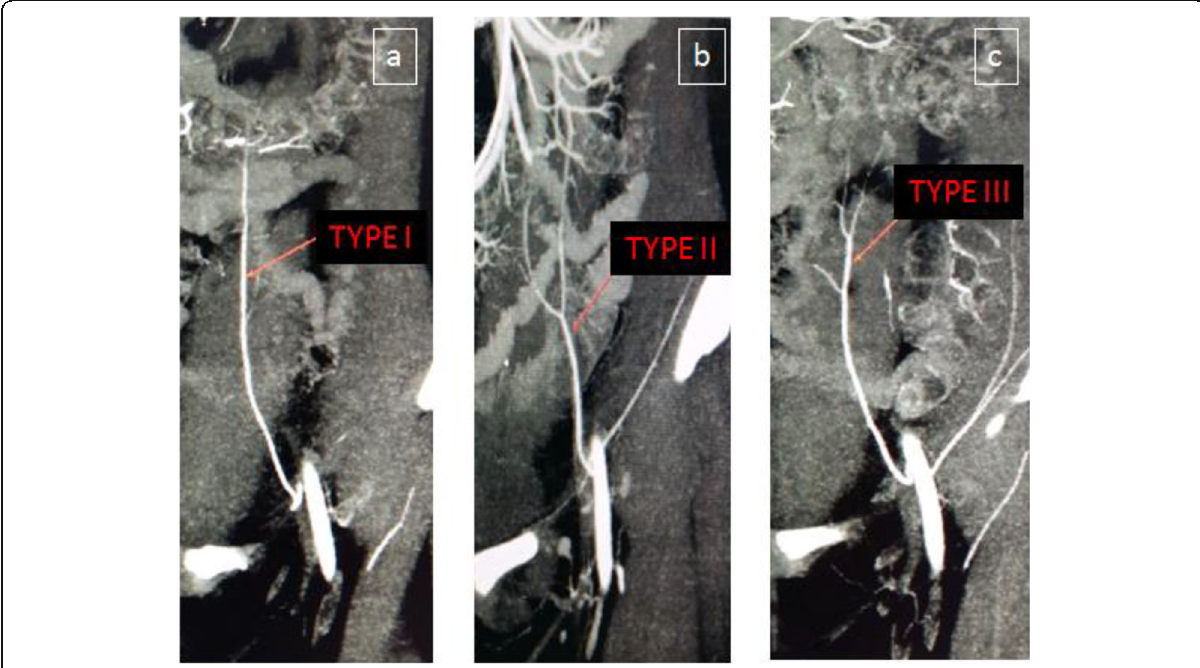
Fig. 5 Coronal maximum intensity projections (MIP) showing the three different branching patterns of the deep inferior epigastric artery according to the Moon and Taylor classification as follows: a a single trunk, b bifurcating into medial and lateral branches, or c subdividing into three or more